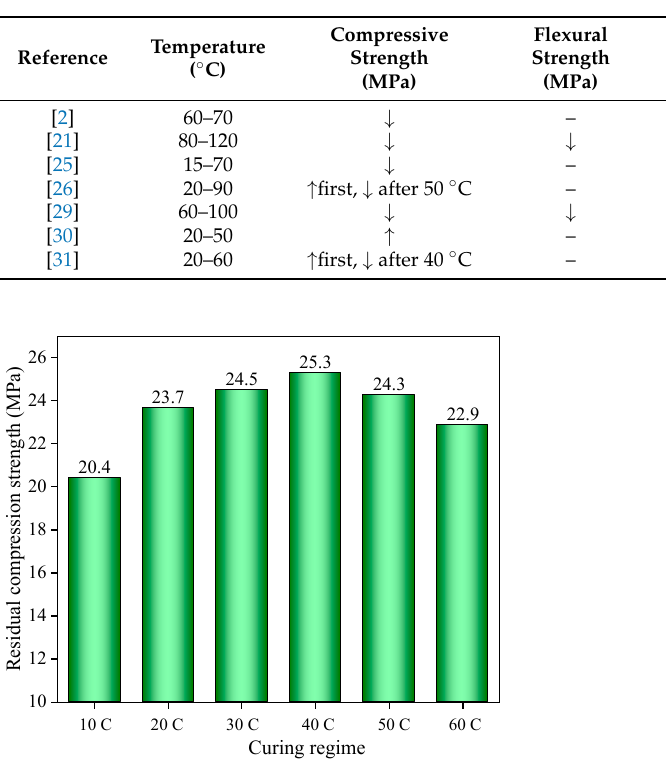
Table 8. Effect of curing temperature on the performance of specimens.